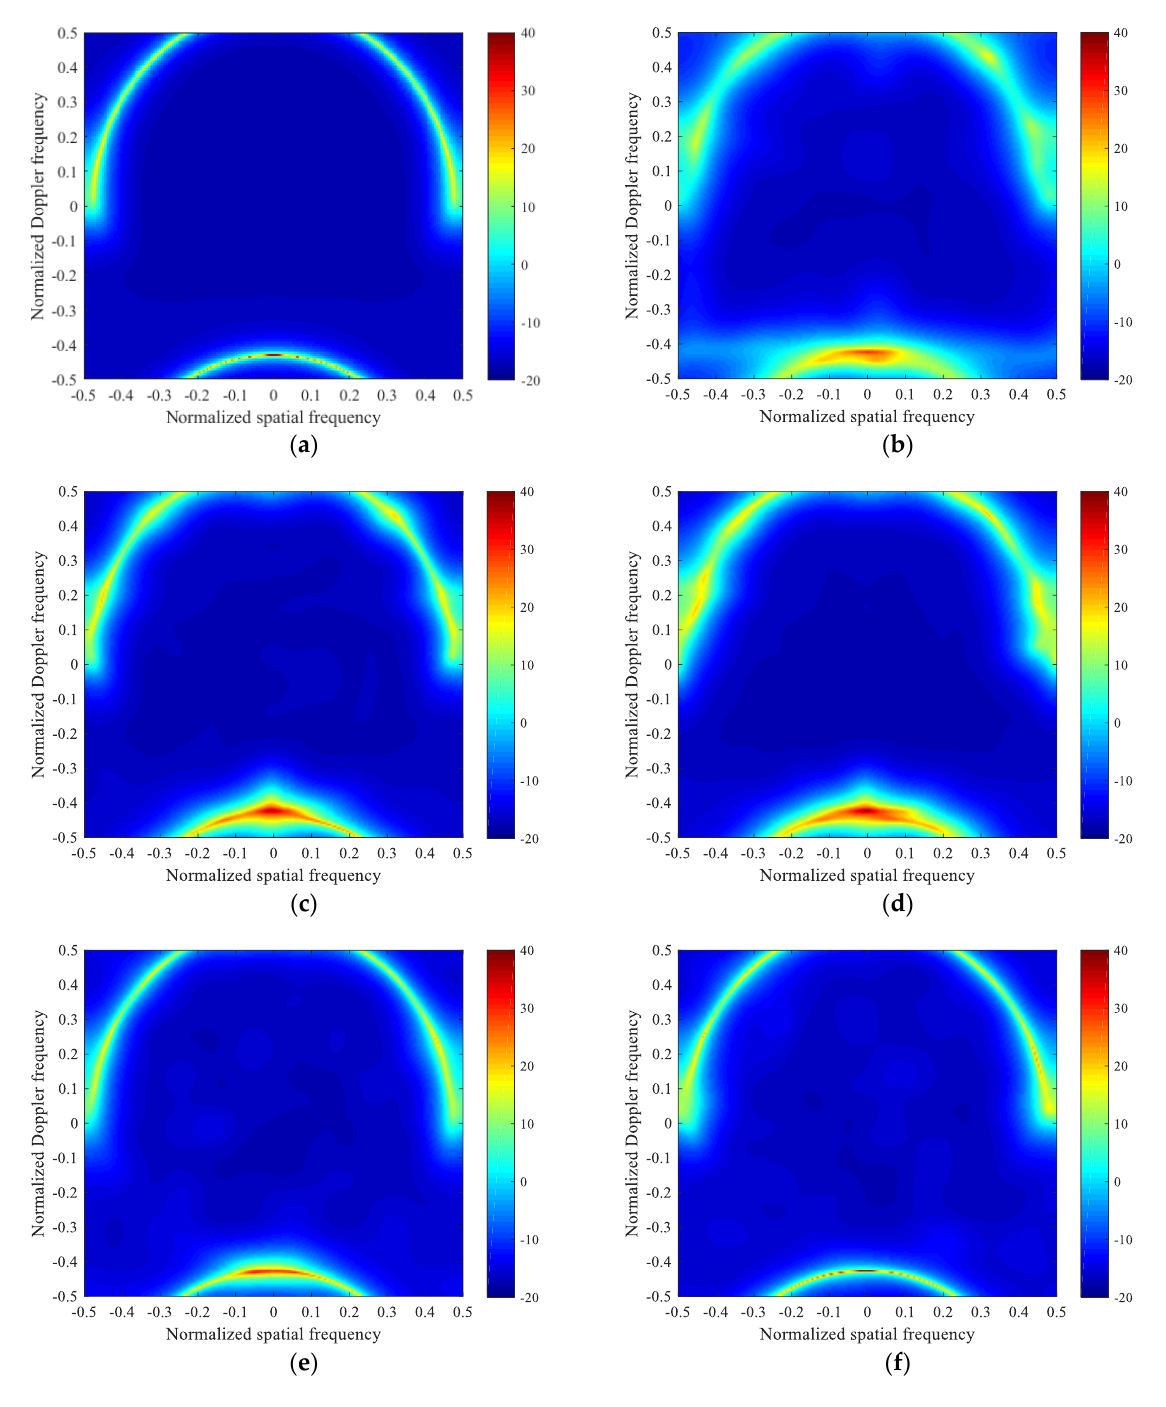
Figure 4. Comparison between the clutter angle-Doppler spectrum estimated by different algorithms for a forward-looking radar. ( a ) Ideal clutter spectrum; ( b ) M-FOCUSS, ϕ = 5; ( c ) M-SBL, ϕ = 5; ( d ) the proposed algorithm, ϕ = 5; ( e ) the proposed algorithm, ϕ = 15; ( f ) the proposed algorithm, ϕ =